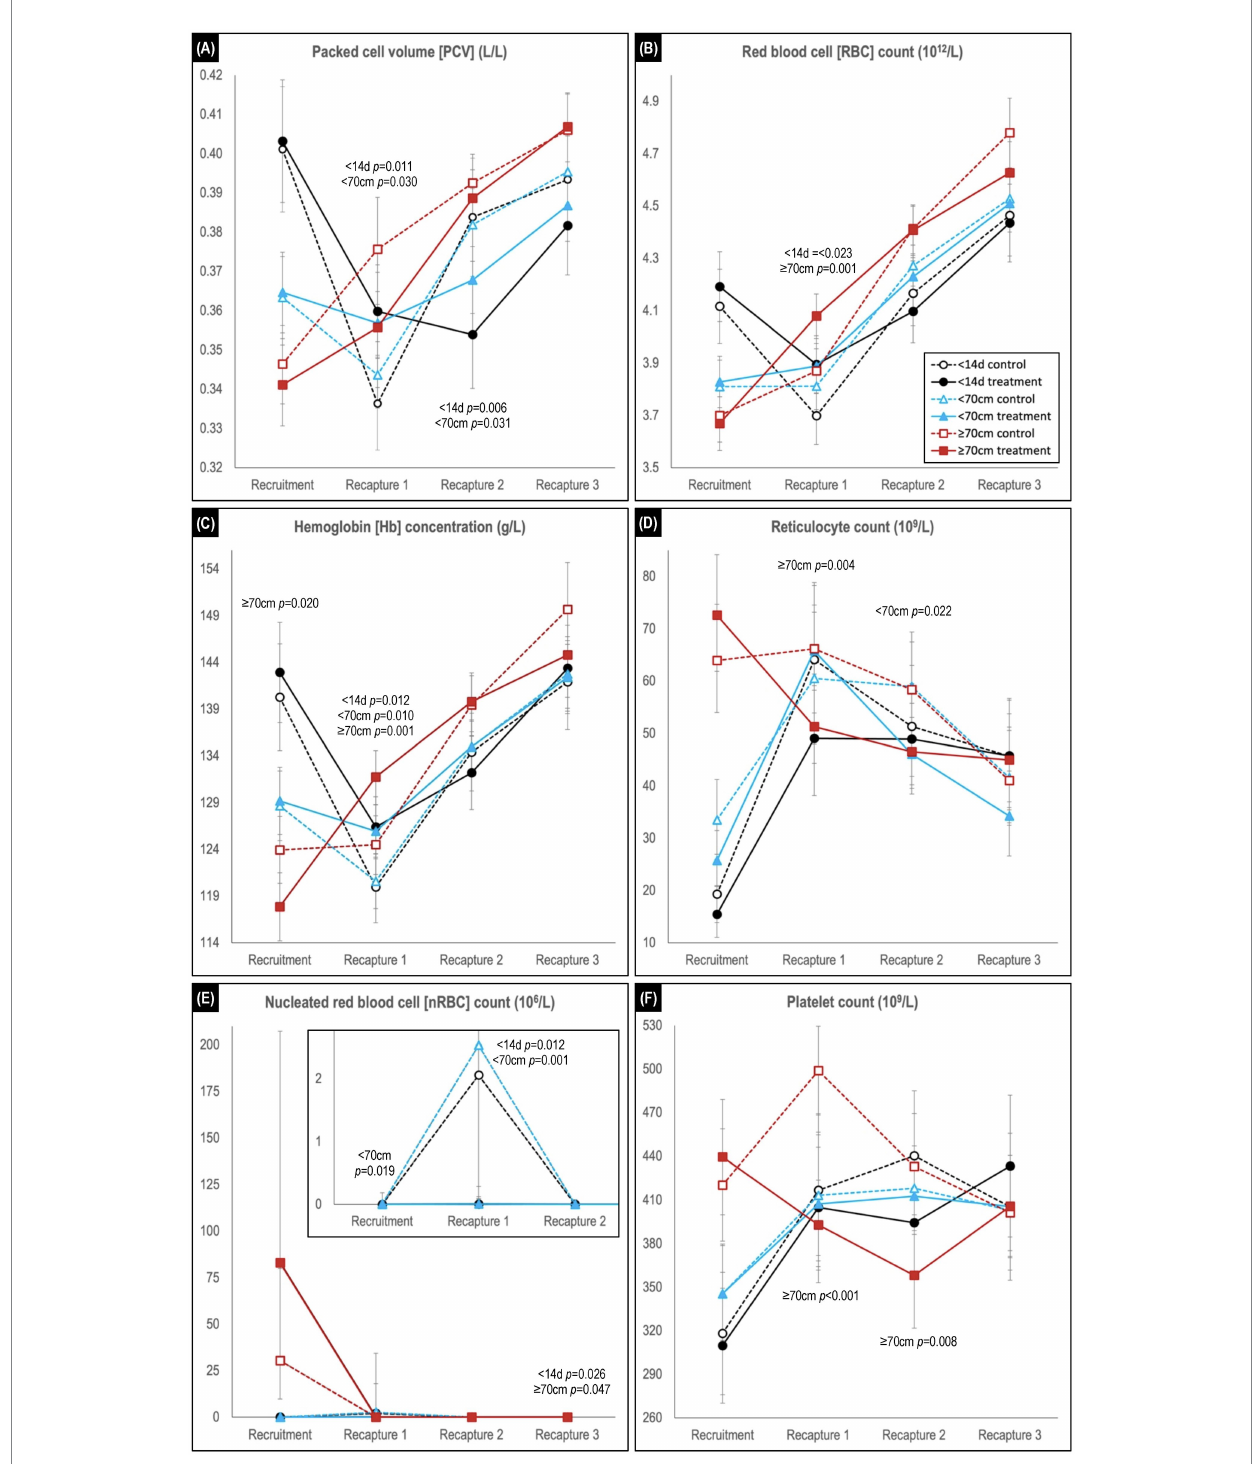
FIGURE 4 Comparison of predicted mean or median* values (and 95% confidence intervals) for (A) packed cell volume, (B) red blood cell count, (C) hemoglobin concentration, (D) reticulocyte count, (E) nucleated red blood cell count, and (F) platelet count in hookworm treated and control groups of Australian sea lion pups. Results are stratified by pup recruitment age (size) cohorts – <14 d prepatent, <70 cm standard length and ≥ 70 cm standard length. Significant between treatment group differences within any of the three age cohorts are listed adjacent to the respective capture. Differences between treatment groups within the same age cohort quantify the impact of hookworm infection, which is superimposed on temporal changes attributable to age-related hematological ontogenesis in maturing pups. The median interval (and range) for the recruitment-to-recapture 1, recapture 1-to- recapture 2, and recapture 2-to-recapture 3 periods for the combined cohorts were 31 d (15–111 d), 31 d (20–99 d), and 33d (20–99 d), respectively. E shows a magnification of the results for the <14 d and <70 cm cohorts for the first 3 captures. *Transformed model estimates and their associated 95% CI boundaries were back transformed prior to reporting and should be interpreted as medians rather than means (refer to Supplementary Table S2 for specific detail values of transformed